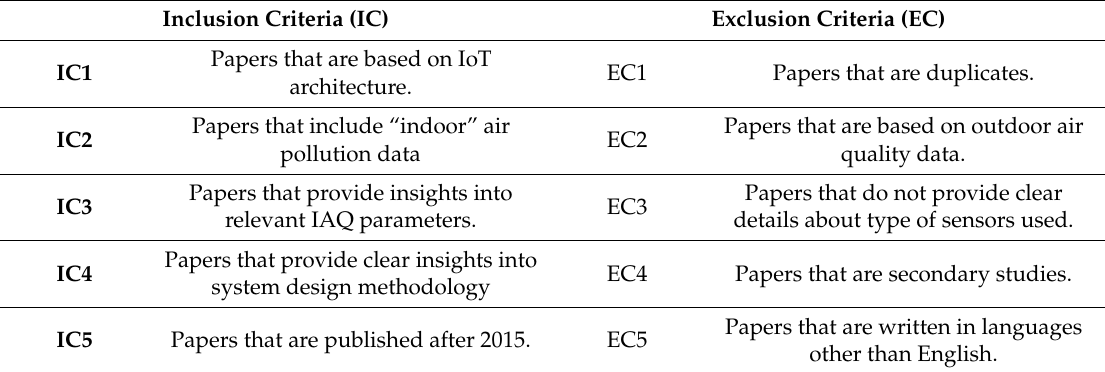
Table 1. Inclusion and exclusion criteria for systematic